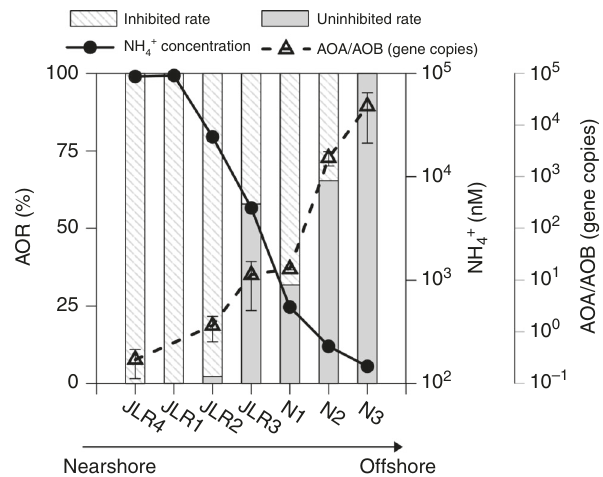
Fig. 4 Rate inhibition along a substrate gradient. Proportional contributions of inhibited (slashed bars) and uninhibited (gray bars) ammonia oxidation rate by allylthiourea (ATU) to the bulk ammonia oxidation rate, the in situ ammonium concentration (solid line/ fi lled circles) and the ratios of ammonia-oxidizing archaeal (AOA) vs. bacterial (AOB) amo A gene copy numbers (dashed line/open triangles). The gene copies data are expressed as the mean values ± SD ( n = 3 independent experiments).